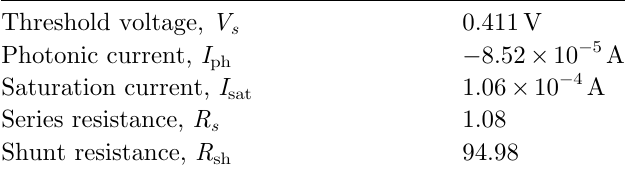
Table 1. Electrical parameters of germanium